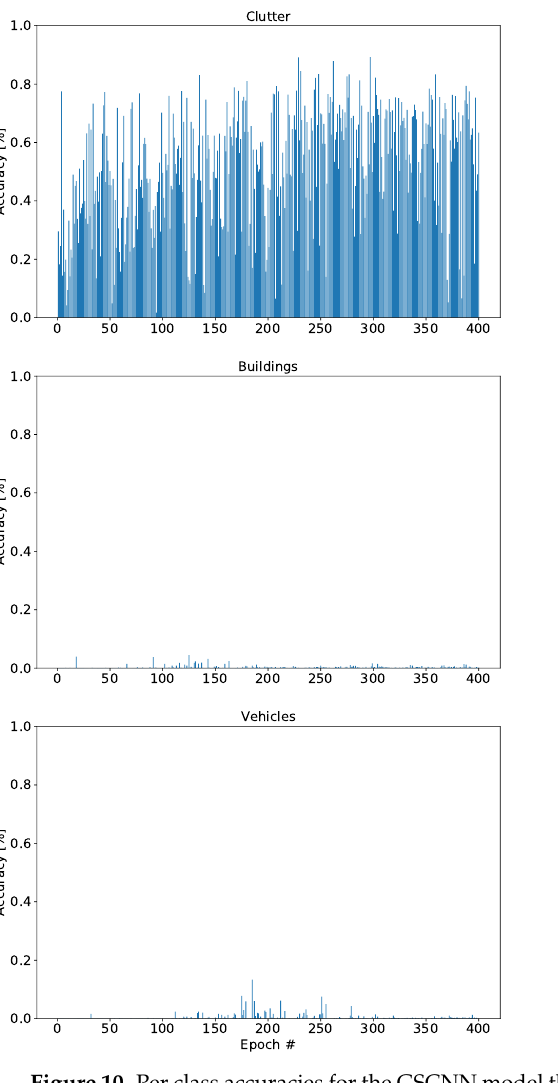
Figure 10. Per class accuracies for the GSCNN model that is trained on coordinates and colors, and uses a weighted loss, after each